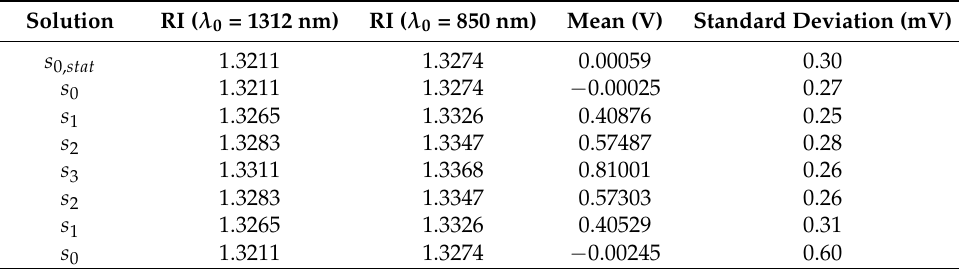
Table 2. Refractive index (RI) at λ 0 = 1312 nm and λ 0 = 850 nm, mean (time-averaged) differential output voltage, and standard deviation over time of the differential output voltage for each solution injected, as measured at the angle of incidence θ r (right working point). The RI at λ 0 = 850 nm were calculated using the dispersion coefficients of water and glycerol and the Sellmeier dispersion equation reported in